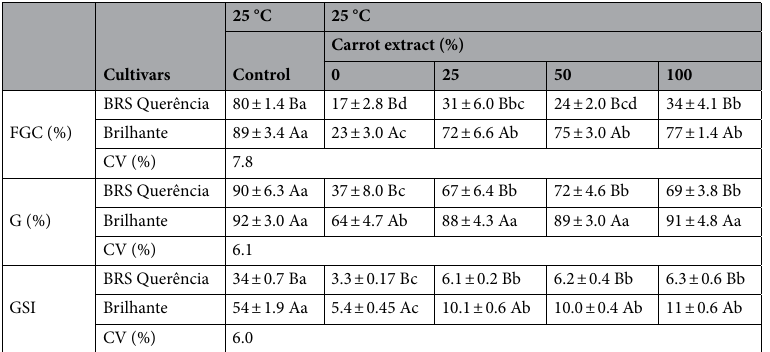
Table 2. First germination count (FGC), germination test (G), and germination speed index (GSI) of rice seeds, cv. BRS Querência and cv. Brilhante in response to conditioning on carrot extract and low temperature. Means followed by the same letter, upper case in the column and lower case in the row, do not differ by Tukey’s test (P ≤ 0.05). CV coefficient of variation, ± SD standard